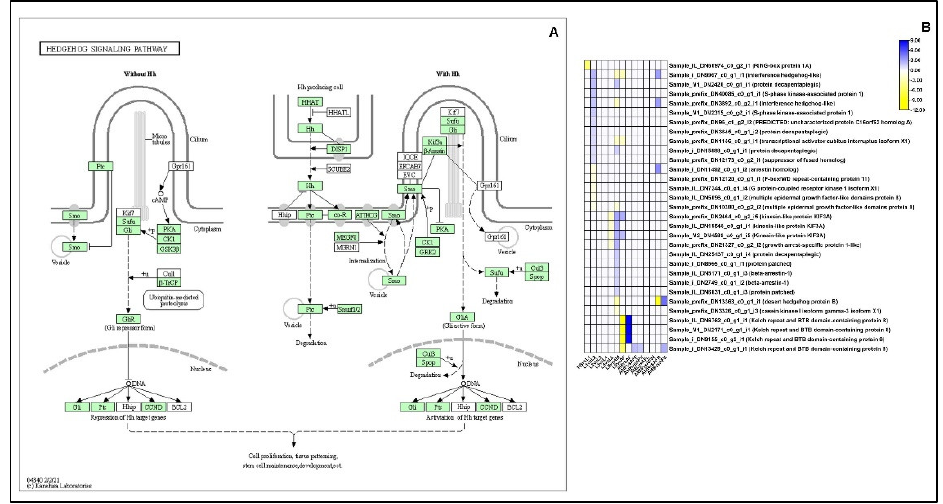
Figure 9. Identification of genes assigned to the Hedgehog signaling pathway in the P. bremeri transcriptome. KAAS was used to identify genes annotated by BLAST against the specific insect database and assigned to a KEGG pathway ( A ) Hedgehog signaling pathway components/genes. Colored boxes indicate the presence of the genes identified. A green colored box signifies the presence of an annotated gene that does not show a change in expression levels. ( B ) Heat map showing the log2-fold change of the FPKM values of the DEGs.